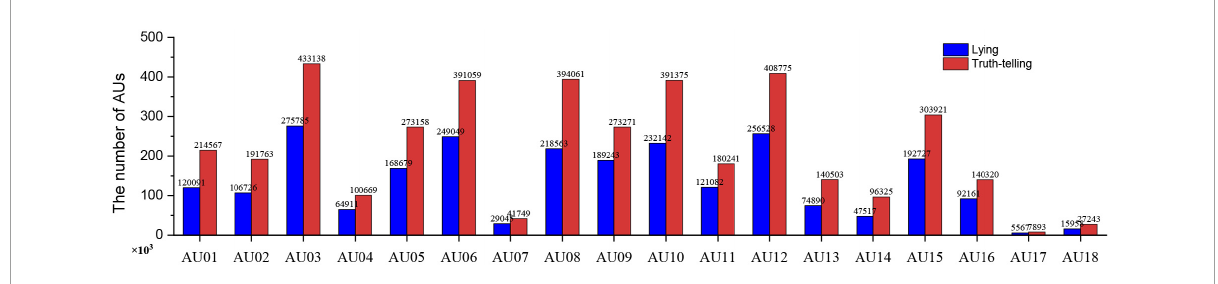
FIGURE2 Number of action units (AUs) indicating lying and